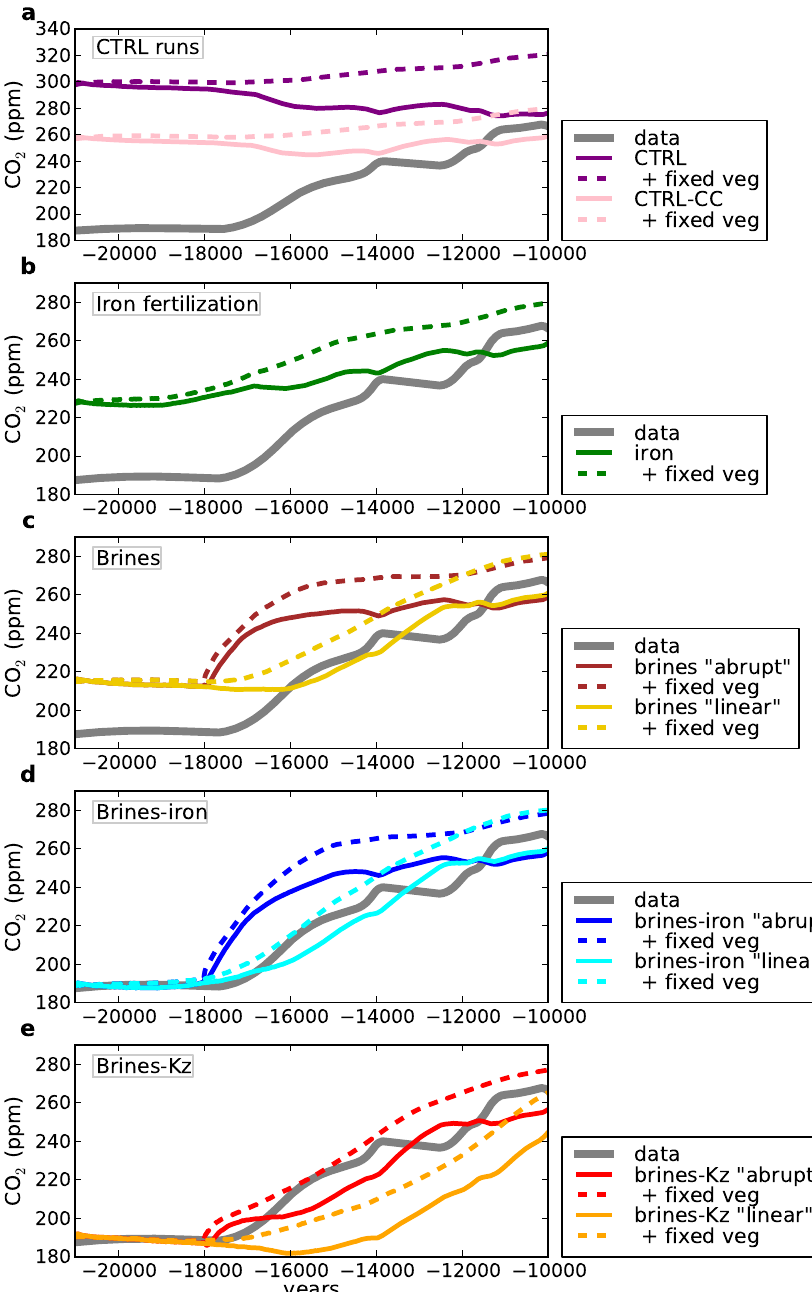
Fig. 8. Evolution of atmospheric CO 2 during the last deglaciation with different oceanic mechanisms and comparison with data: (a) control (CTRL) runs without and with carbonate compensation (CC), all other simulations are with carbonate compensation, (b) simulations with iron fertilization, (c) simulations with the sinking of brines (two scenarios as defined in Fig. 6), (d) simulations with the sinking of brines (two scenarios as defined in Fig. 6) and iron fertilization, (e) simulations with the sinking of brines (two scenarios as defined in Fig. 6) and interactive vertical diffusion coefficient ( K z ). Each simulation has either an interactive vegetation or a fixed glacial vegetation (“fixed veg”). The data are from Monnin et al. (2001); Lourantou et al.